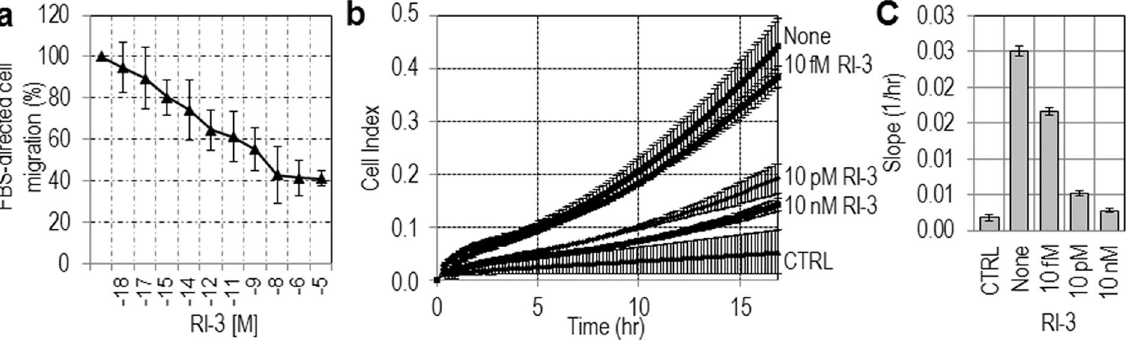
Figure 4. RI-3 inhibits migration and invasion of HT1080 cells in a dose dependent manner. ( a ) HT1080 cells were allowed to migrate in Boyden chambers for 4 hr toward 10% FBS plus increasing concentrations of RI-3. Value assessed in the presence of FBS alone was taken as 100% and all values were reported relative to that. Data are the means ± SD of three independent experiments, performed in triplicate. ( b , c ) HT1080 cells were allowed to invade matrigel in real time for 20 hr toward DMEM (CTRL), 10% FBS (None), or 10% FBS plus increasing concentrations of RI-3. Data represent mean ± SD from a quadruplicate experiment. Slopes ( c ) represent the change rate of cell index values generated in a 0–18 hr time